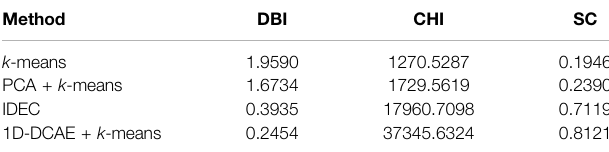
TABLE 2 | Comparative analysis of cluster indexes. Method